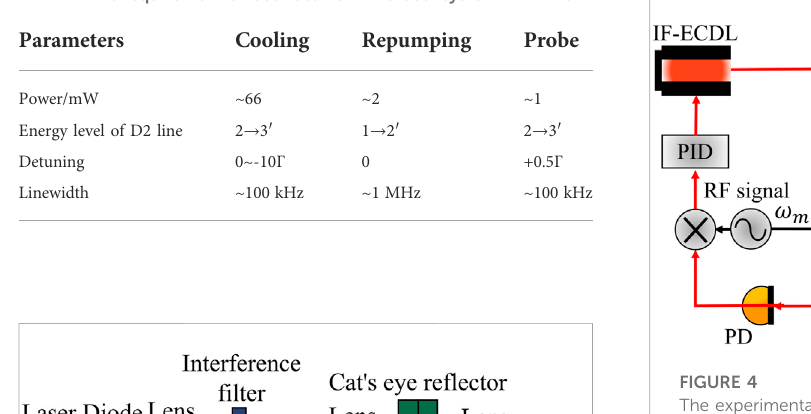
FIGURE 4 The experimental set-up for the frequency stabilization by